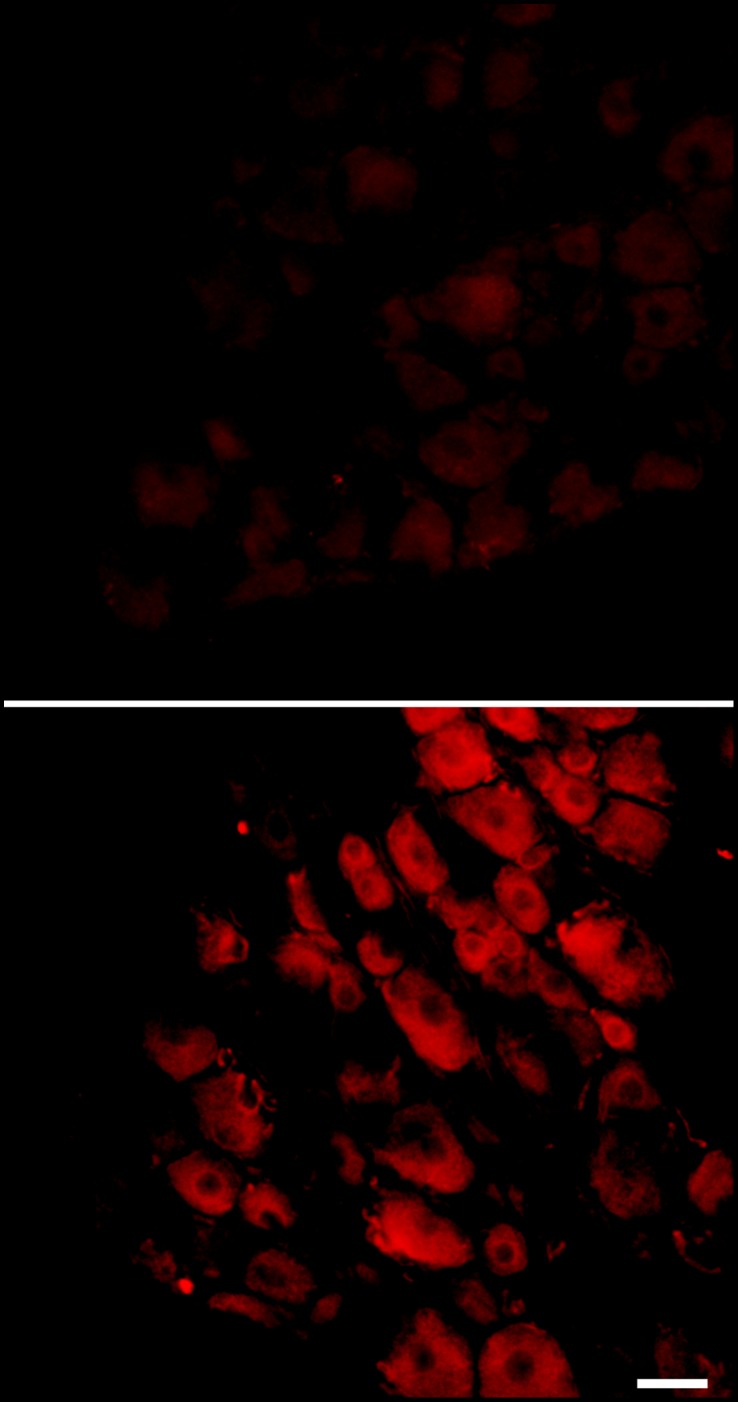
Examples of Cxcl14 staining (red) in DRG sections.Top panel, in normal DRG; bottom panel, 3 days after DRG inflammation.